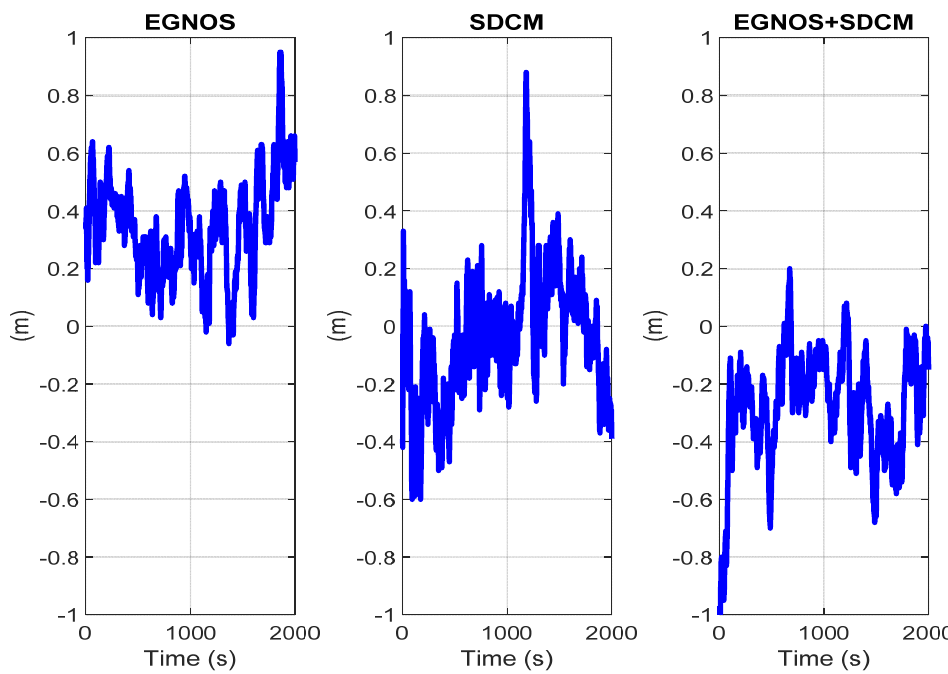
Figure 19. Validation of EGNOS, SDCM, and EGNOS+SDCM positioning based on the values ∆ 3 D , SBAS (see Equation (37)).